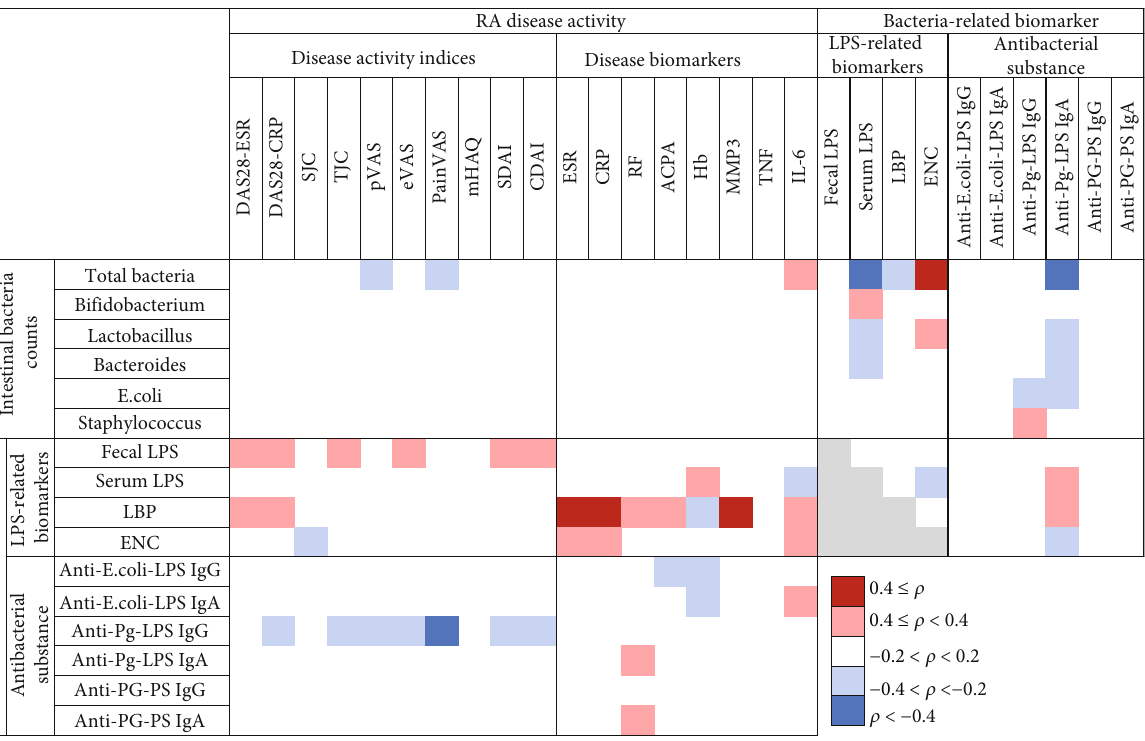
Figure 2: Relationship of intestinal bacterial counts and bacteria-related biomarkers with RA disease activities. The relationships between variables were expressed as Spearman ’ s correlation coe ffi cient ( ρ ). Light and dark red color: positive correlations, light and dark blue color: negative correlations, and gray color: not analyzed. DAS28: disease activity score with 28 joint counts; ESR: erythrocyte sedimentation rate; CRP: C-reactive protein; SJC: swollen joint count; TJC: tender joint counts; pVAS (eVAS): patient ’ s (evaluator ’ s) visual analogue scale; painVAS: VAS for pain; mHAQ: modi fi ed health assessment questionnaire; CDAI: clinical disease activity index; SDAI: simpli fi ed disease activity index; RF: rheumatoid factor; ACPA: anticyclic citrullinated peptide antibody; Hb: hemoglobin; MMP3: matrix metalloproteinase-3; TNF: tumor necrosis factor alpha; IL-6: interleukin-6; LPS: lipopolysaccharide; LBP: LPS-binding protein; ENC: endotoxin neutralizing capacity; Pg-LPS: LPS from Porphyromonas gingivalis; PG-PS: peptidoglycan